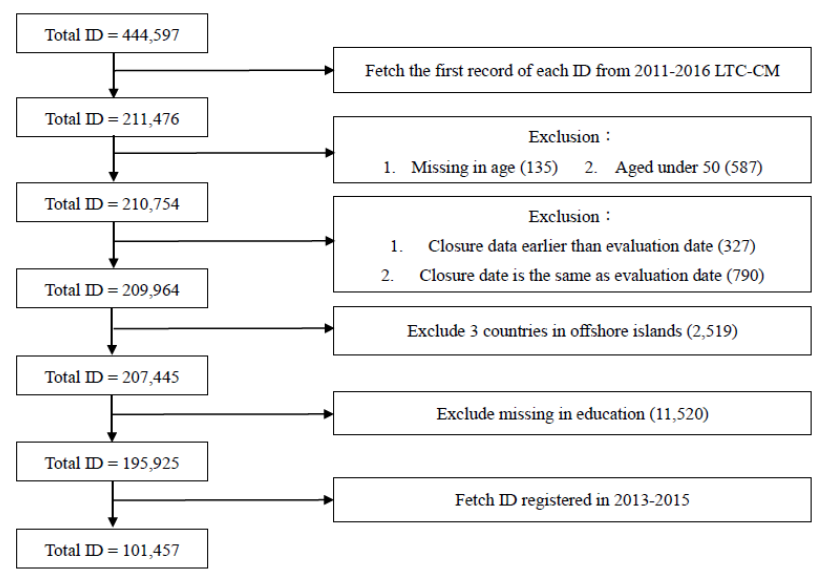
Figure 1. Flow chart of the exclusion process. ID: Identification number for citizens in Taiwan